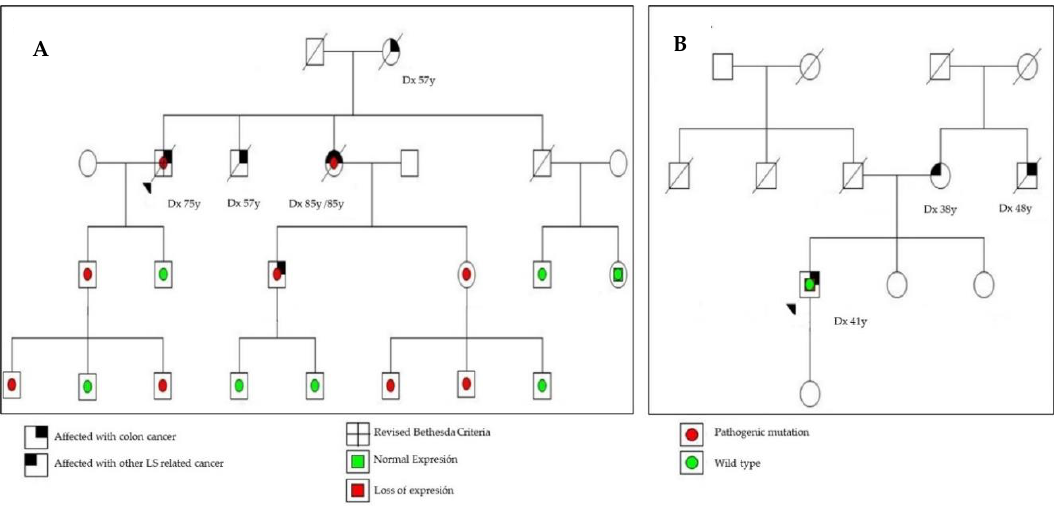
Figure 2. Examples of pedigrees of Lynch syndrome ( A ) and Lynch-like syndrome ( B ) families. LS, Lynch syndrome; Dx, diagnosis, Y, years. Table 1. Characteristics of patients with LS and LLS.